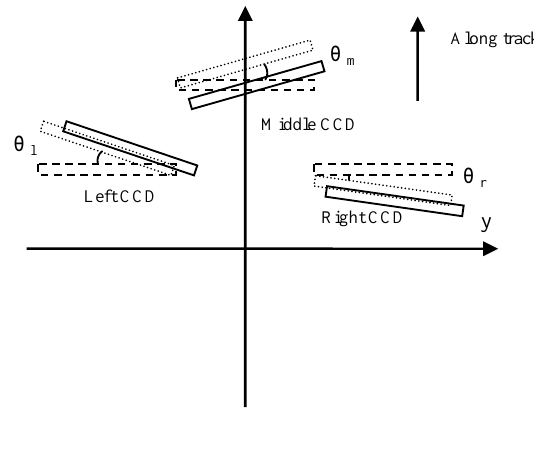
Figure 2 CCD rotation and translation on the focal plane Coordinates of image points on left, middle and right